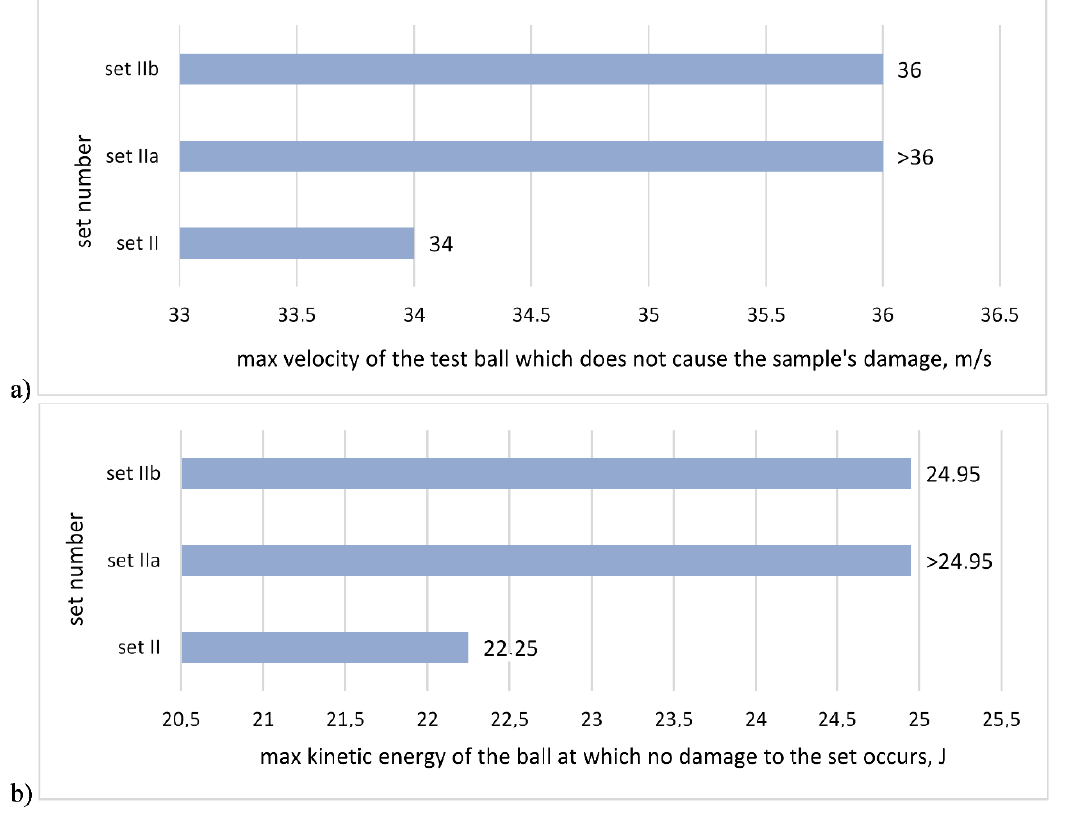
Figure 6. Results of hail stone puncture resistance tests for sets with di ff erent meshes and the same polymer dispersion adhesive: ( a ) in reference to the maximum velocity of the test ball which does not cause the sample’s damage, ( b ) calculated as the maximum kinetic energy of the test ball, which does not cause the sample ’s damage.